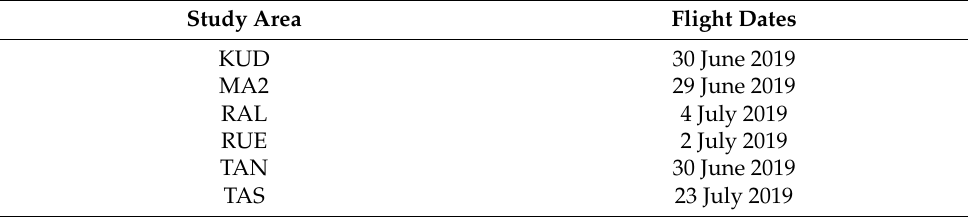
Table 2. Flight dates in each study